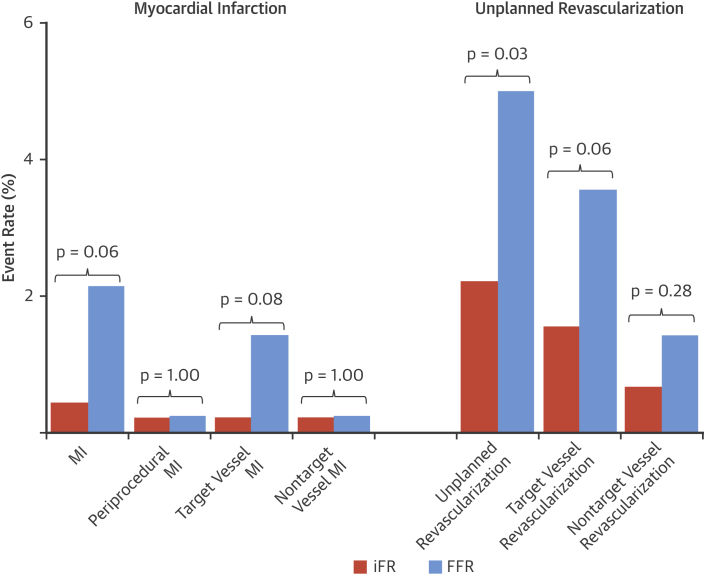
Summary of Clinical Events in LAD-Deferred PatientsBar charts outlining clinical events in patients with LAD stenoses deferred on the basis of intracoronary physiology. The orange bars denote patients whose treatment was guided by iFR, and the blue bars denote patients whose treatment was guided by FFR. iFR-guided deferral was associated with significantly lower rates of unplanned revascularization (right, p = 0.03). This was driven by numerically greater rates of target vessel revascularization with FFR (p = 0.06). iFR-guided deferral was associated with numerically lower rates of myocardial infarction (MI) (left, p = 0.06). This was driven by numerically greater rates of target vessel MI with FFR (p = 0.08). There was no difference in periprocedural MI (p = 1.00). Abbreviations as in Figure 1.